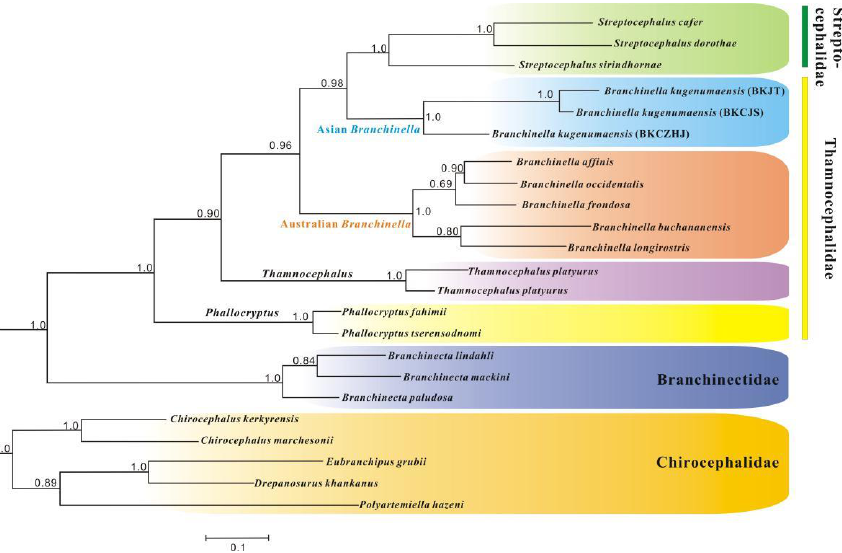
Figure 4. Bayesian tree of Thamnocephalidae (color-coded) derived from mitochondrial 16S rRNA and cox1 gene sequence datasets. Bayesian posterior probability support values are reported on the nodes.